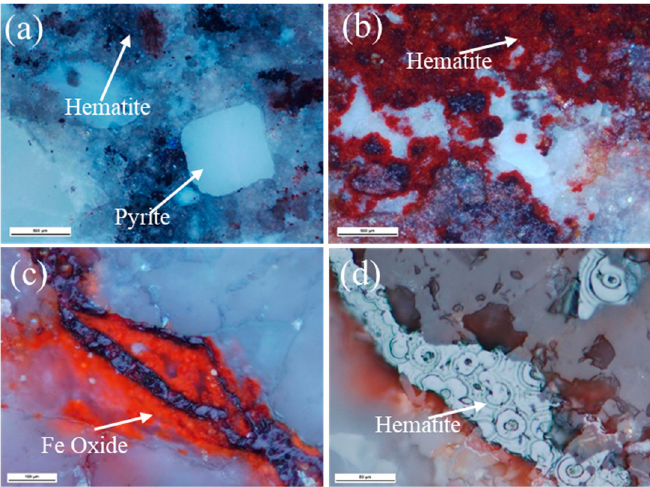
Figure 3. Reflected light microphotographs of the hematite in the oxidation zone sample. ( a – c ) are in cross ‐ polarized light and ( d ) is in plane ‐ polarized light.